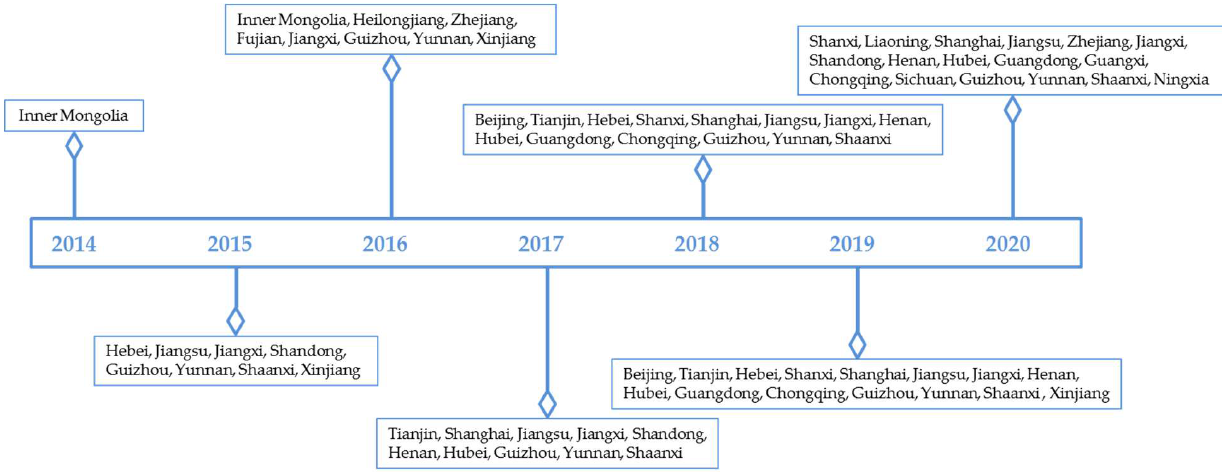
Figure 2. Timeline of Provinces to implement WSMC programs.